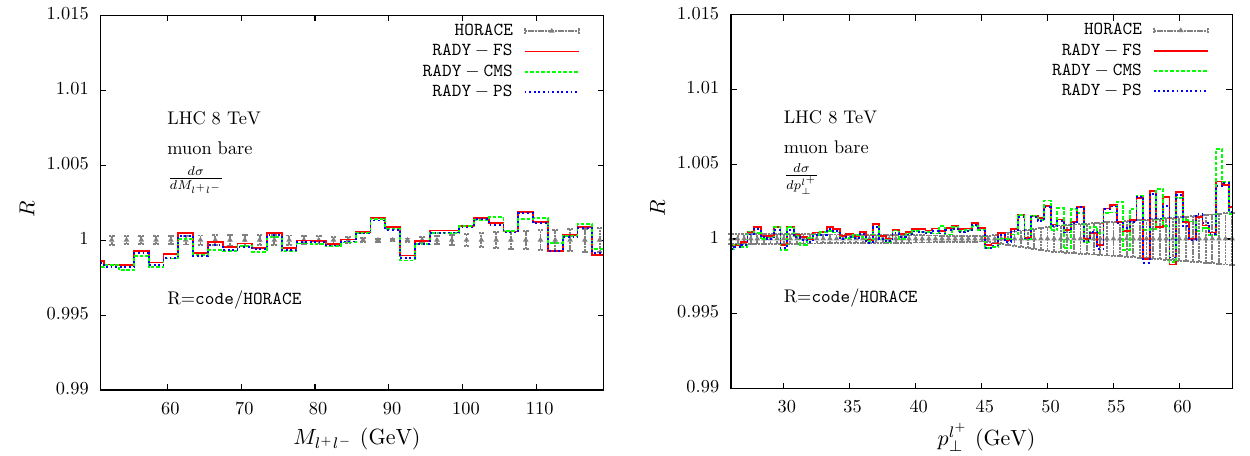
pp → γ, Z → μ + μ − + X at the 8 TeV LHC with ATLAS/CMS cuts in the bare setup. The definitions of the FS, CMS and PS schemes can be found in Ref. [18]